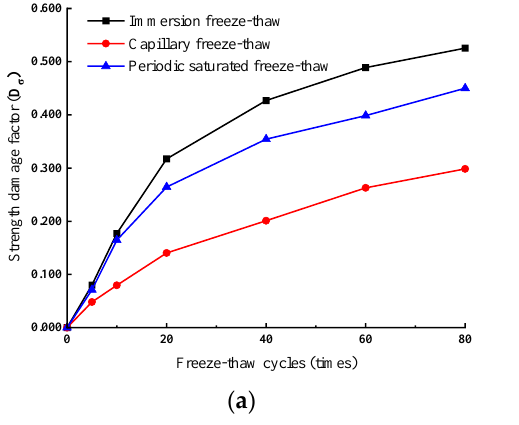
Figure 18. Rock damage factor variation curves under freeze–thaw action. ( a ) Strength damage factor variation curve; ( b ) wave velocity damage factor variation curve